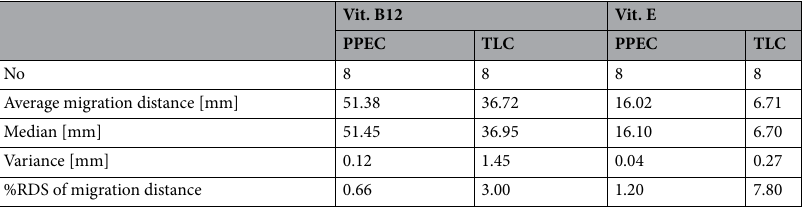
Table 1. Statistical evaluation of PPEC and TLC experimental results. The mobile phase consisted of 50% acetonitrile, 18.75 mM SDS and a buffer solution of pH 6.99 ((acetic acid, phosphoric acid, and boric acid (2.74 mM each) and sodium hydroxide (8.60 mM)). The PPEC polarisation voltage applied was 1200 V, experiment time was 6 min. TLC eluent migration distance was 5 mm, experiment time was 11 min 30 s . Solutes of vitamins B 12 and Vit. E were investigated.